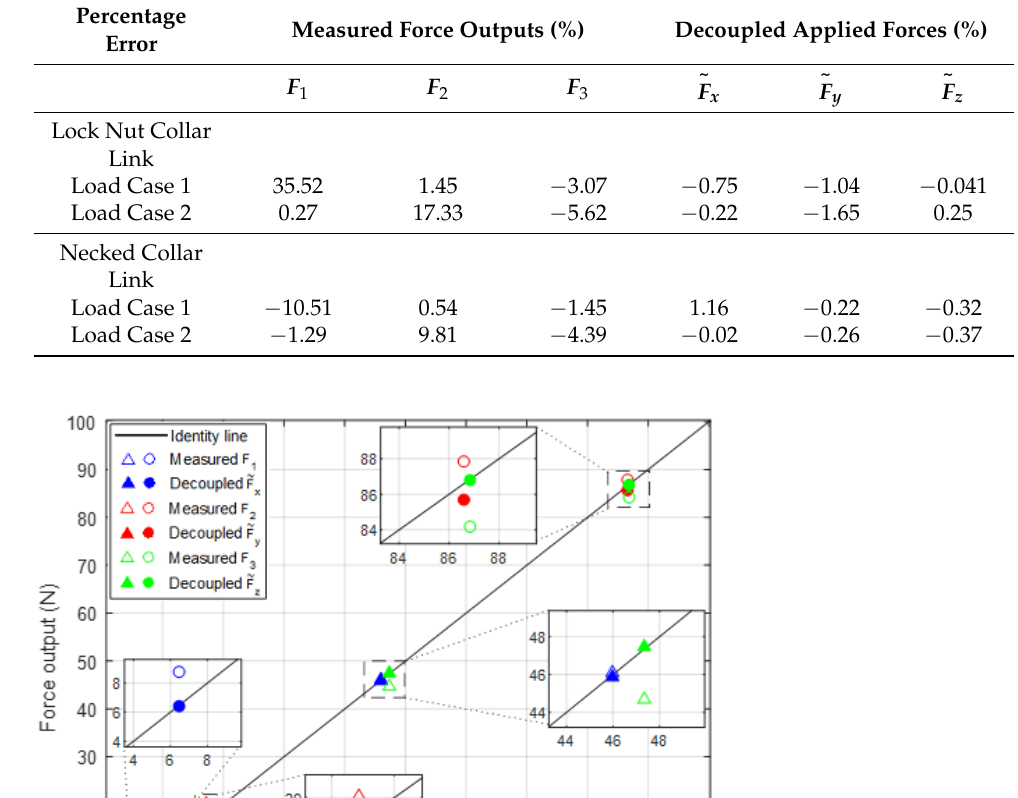
Table 2. Percentage error of the measured forces and decoupled forces for simultaneous loading experiment.